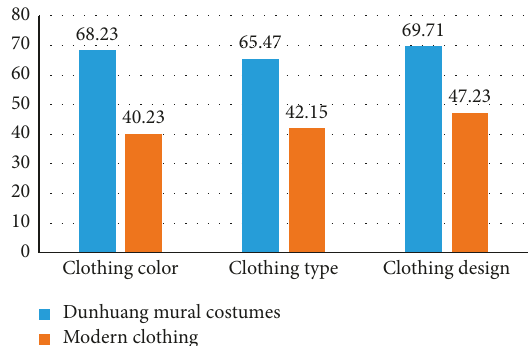
Figure 1: Comparative analysis of characters’ costumes in Dun- huang murals in different